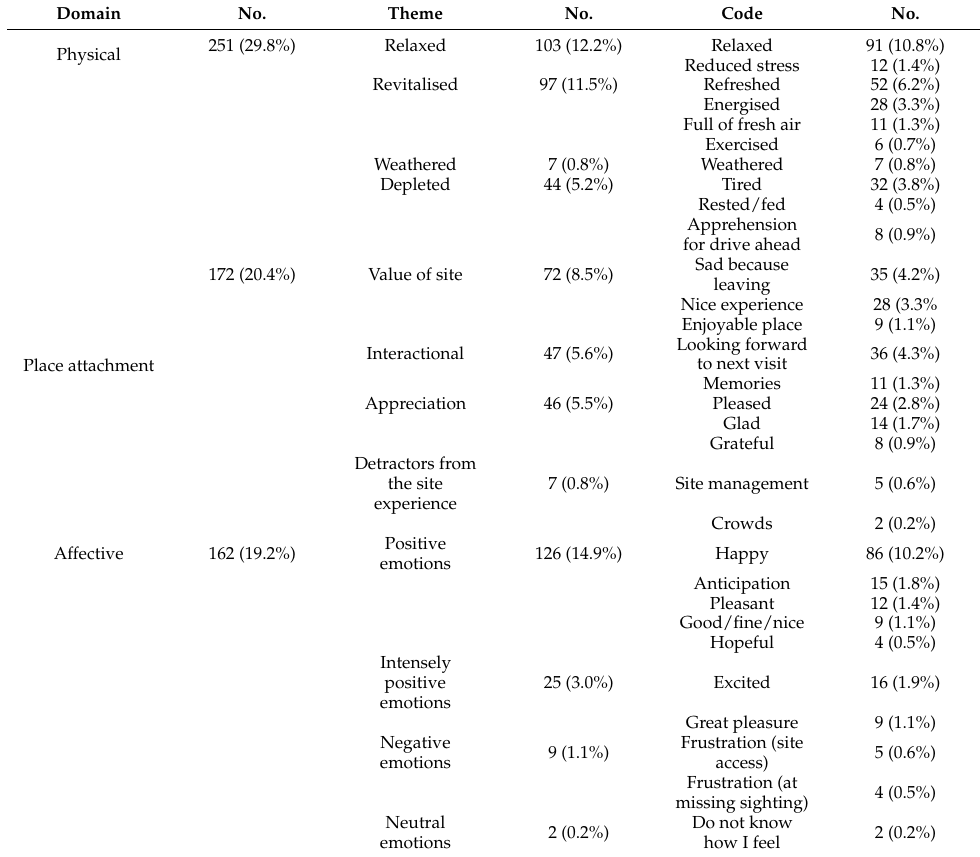
Table 3. Recalled participant-derived effects to visit UK wetland visitor centres from n = 365 partic- ipant responses to the question “Thinking about when you leave a WWT Wetland Centre, please describe how you feel after your visit” via an online survey. The number of assigned meaning units (MUs) per domain, theme or code are presented along with the percentage of total MUs for the question ( n =